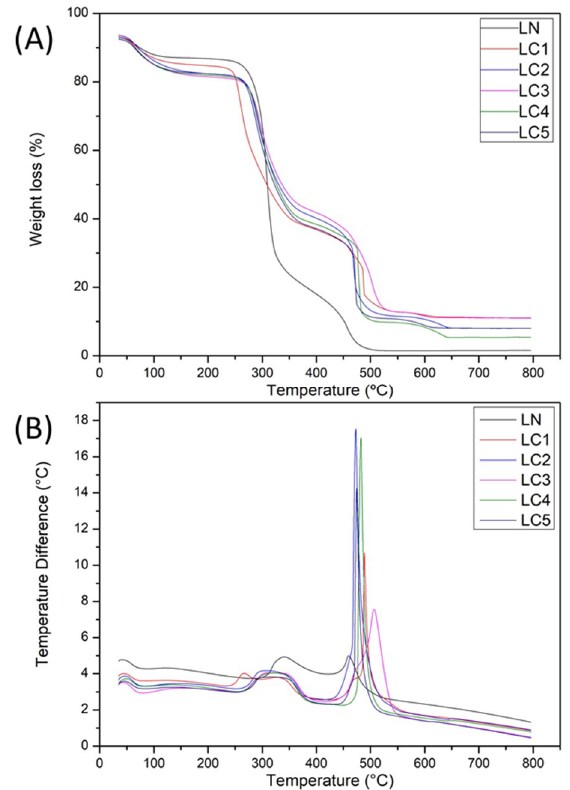
Figure 3. Thermogravimetric ( A ) and differential thermogravimetric ( B ) curves of LN and LC1 (DS: 0.32), LC2 (DS: 0.47), LC3 (DS: 0.51), LC4 (DS: 0.58), and LC5 (DS: